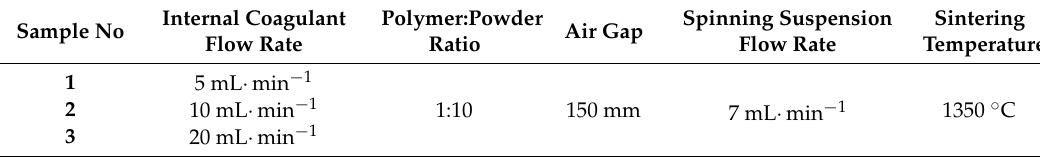
Table 4. Operative conditions used for membranes